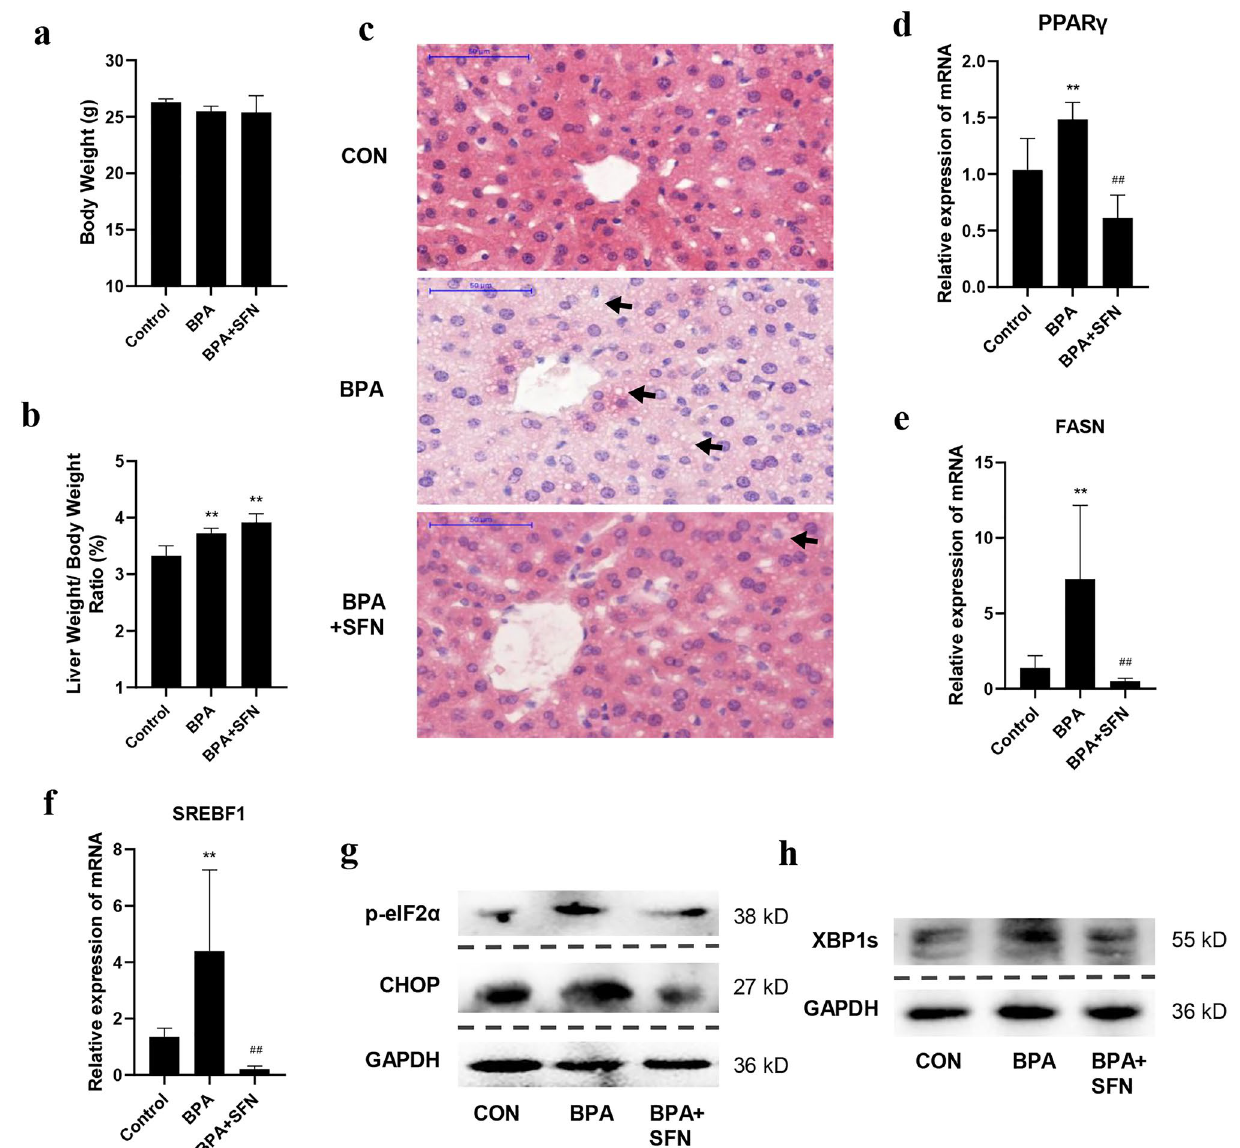
Figure 4. SFN attenuated BPA-induced lipid accumulation and ER stress in mice. C57/BL6J mice were randomly divided into three groups: control, BPA, and SFN intervention group. Mice in BPA group were injected subcutaneously with 100 μg/kg of BPA; mice in SFN group were injected with the same dose of BPA subcutaneously, while 10 mg/kg of SFN were injected intraperitoneally; mice in the control group were injected subcutaneously and intraperitoneally with the same amount of diluted ethanol and corn oil. ( a ) The body weight of each group of mice was weighed. ( b ) The liver of each group of mice was weighed, and the ratio of liver/body weight was calculated. ( c ) H&E of the liver tissues in the experimental mice. The mRNA levels of ( d ) PPARγ, ( e ) FASN, and ( f ) SREBF1 in mice were detected by qRT-PCR. The expression of ( g ) p-eIF2α, CHOP, and ( h ) XBP1s was measured by Western blotting. The blots of p-eIF2α, CHOP, and GAPDH were not cropped from the same membrane, but rather from the same sample. The blots of XBP1s and GAPDH were not cropped from the same membrane, but rather from the same sample. The original blots are presented in Supplementary Figs. 7, 8. Data are expressed as the means ± SD of 6 mice per group. * p < 0.05 and ** p < 0.01, when compared with the control group; # p < 0.05 and ## p < 0.01, when compared with the BPA